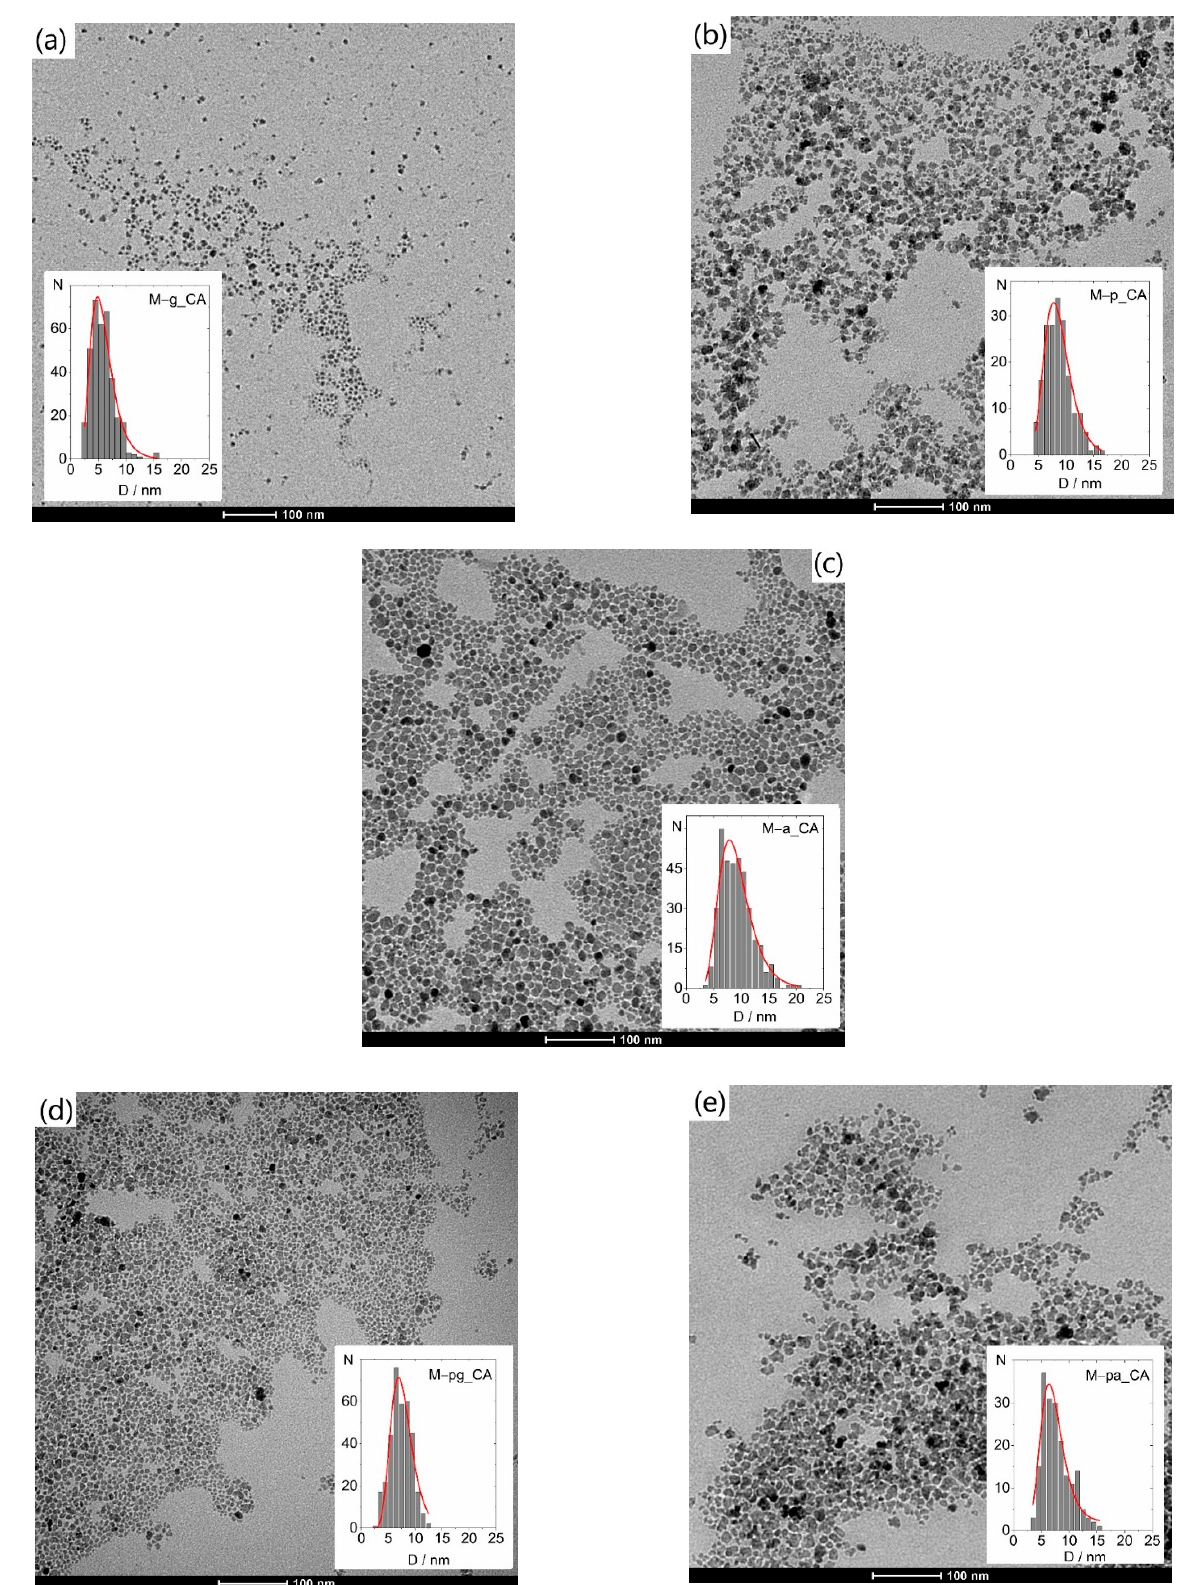
Figure 8. Typical TEM images of the grid ‐ dried citric acid ‐ based ferrofluids and corresponding size distributions for samples ( a ) M1_CA and ( b ) M2_CA.